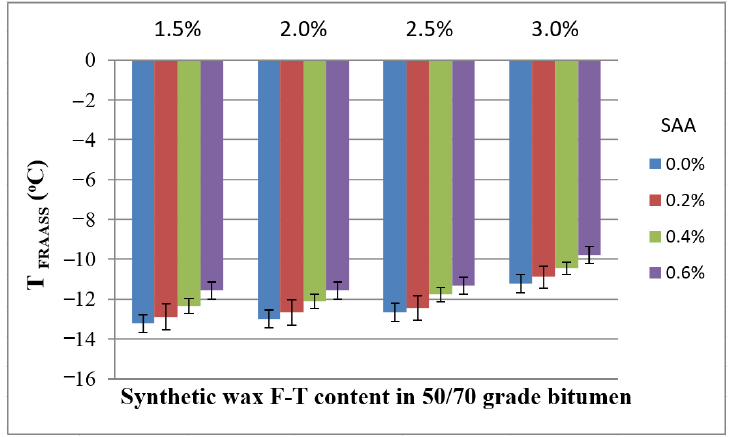
Figure 10. Relationship between the Fraass breaking point of bitumen 50/70 and the contents of F–T wax and SAA.